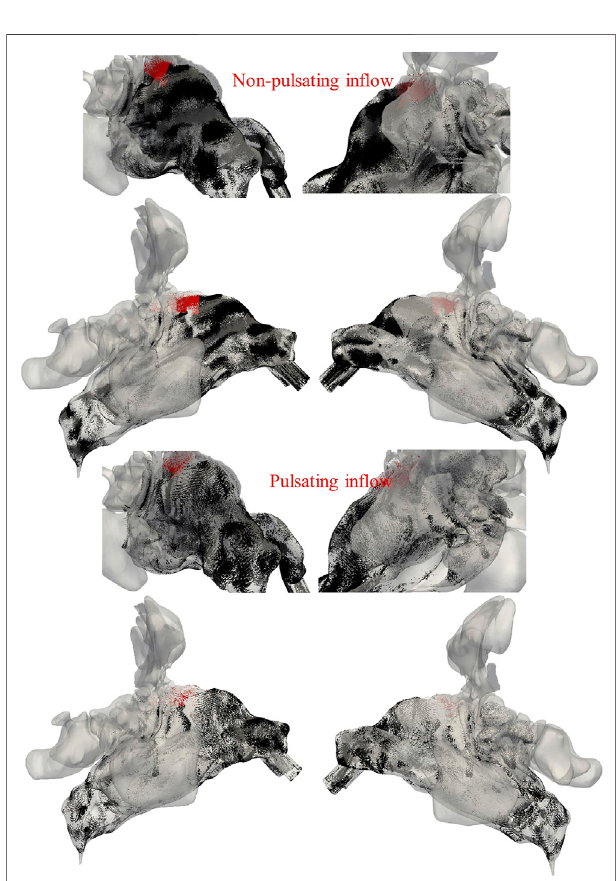
FIGURE 9 | Deposition pattern of 1 µm particles (black spots) for non- pulsatile (top) and pulsatile inlet air fl ows (bottom). The particles deposited in the olfactory region are indicated by red color. Left and right panels refer to views onto the right and left side of the nasal cavity, respectively.